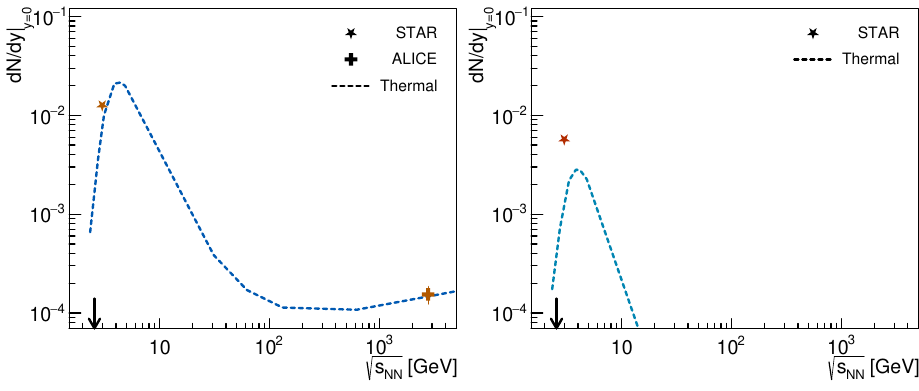
Figure 4. Energy excitation functions of the 3 Λ H (left) and 4 Λ H (right) production rates at mid-rapidity. The data are taken from [7, 21]. The dashed lines correspond to thermal model predictions [22] taken from [7] as